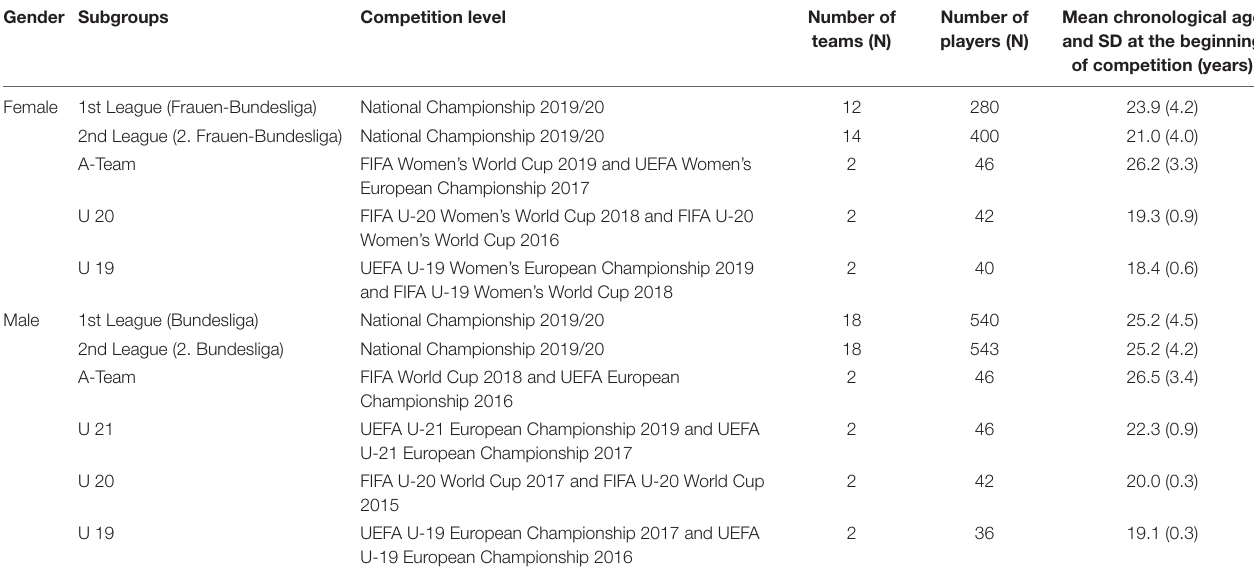
TABLE 1 | Overview of the included female and male elite adult soccer